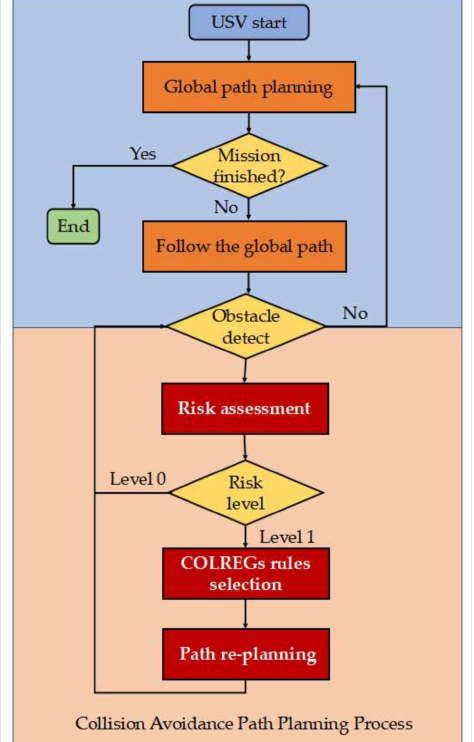
Figure 1. Flowchart of the COLREG-compliant USV collision avoidance path planning